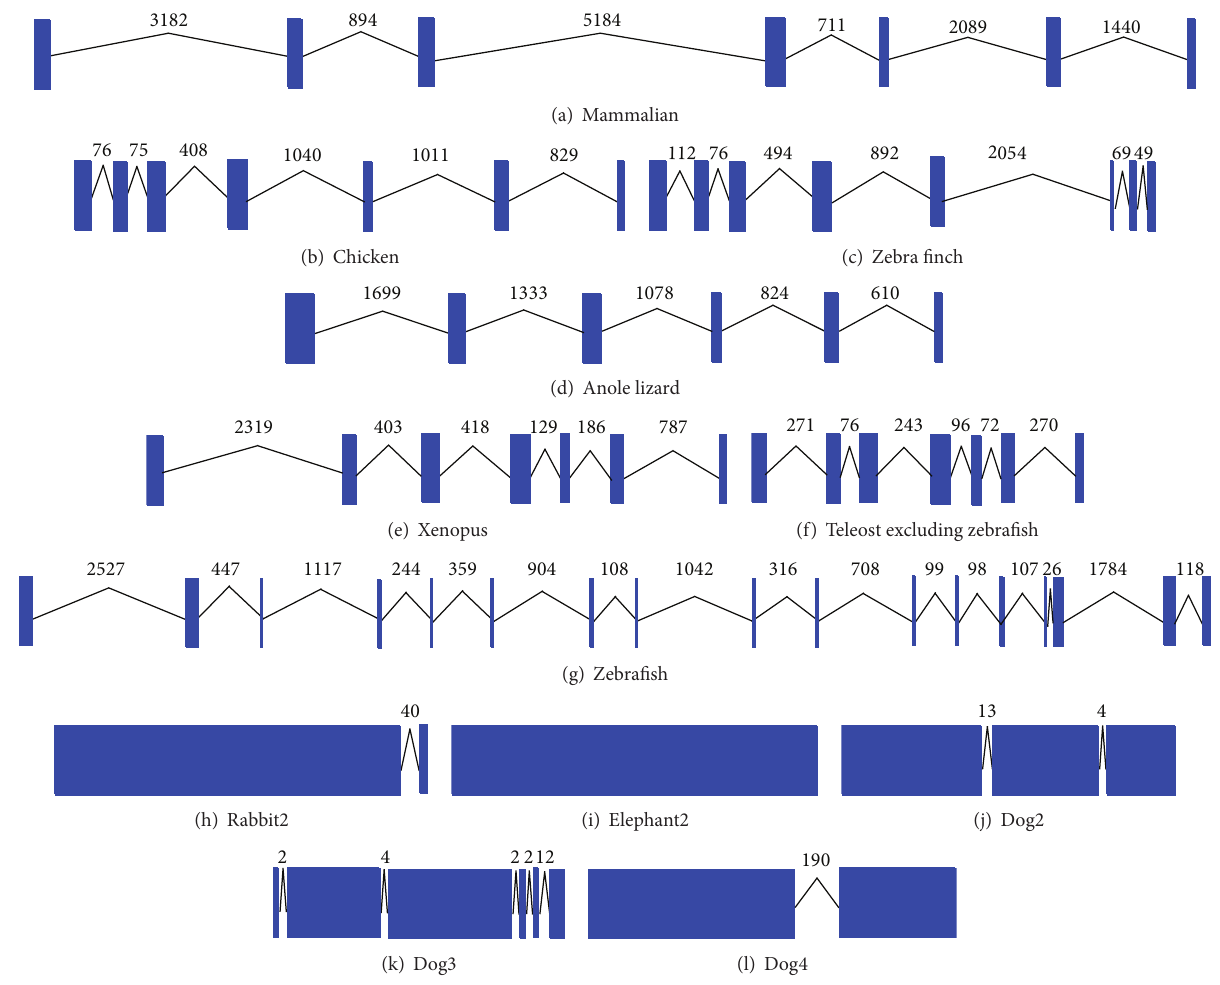
Figure 6: Exon-intron conservation among FKBP25